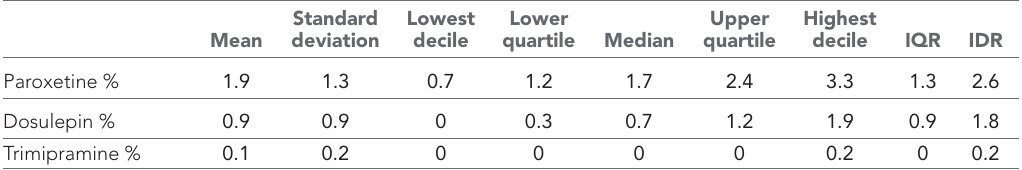
Table 1 Practice- level basic descriptive statistics for the proportions of paroxetine, dosulepin,